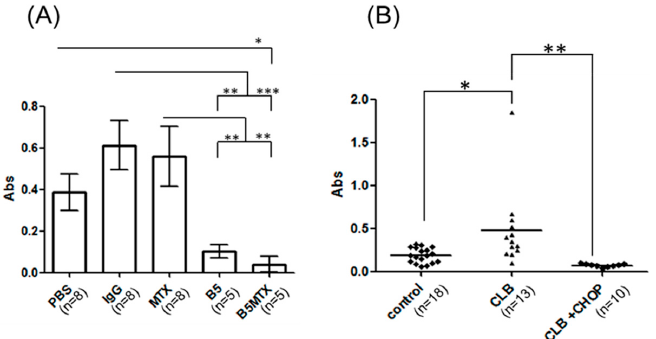
Figure 5. Assessment of soluble DLA-DR levels in blood sera of tumor-bearing NOD-SCID mice ( A ) and healthy dogs or canine lymphoma patients ( B ). Average serum levels (Abs) of DLA-DR in mice